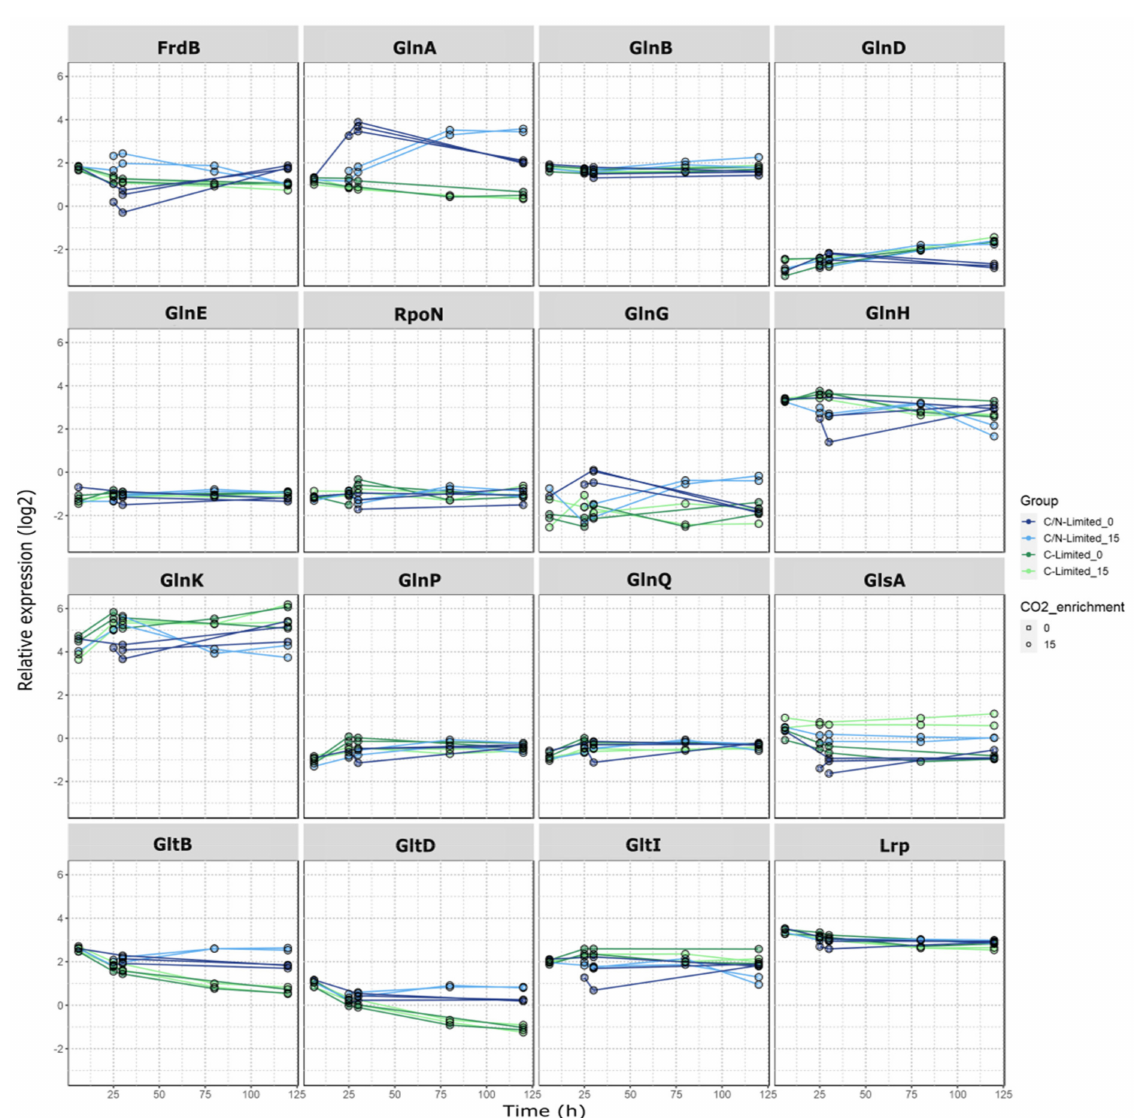
Figure A3. Expression profile of acid stress and nitrogen assimilation related proteins. Y -axis: relative expression in log2 of proteins involved in acid stress response and nitrogen assimilation. X -axis: fermentation time after feed